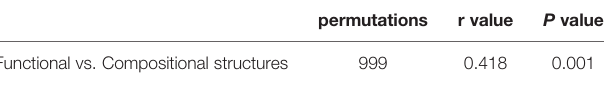
TABLE 1 | Mantel test the correlation between compositional and functional structures.